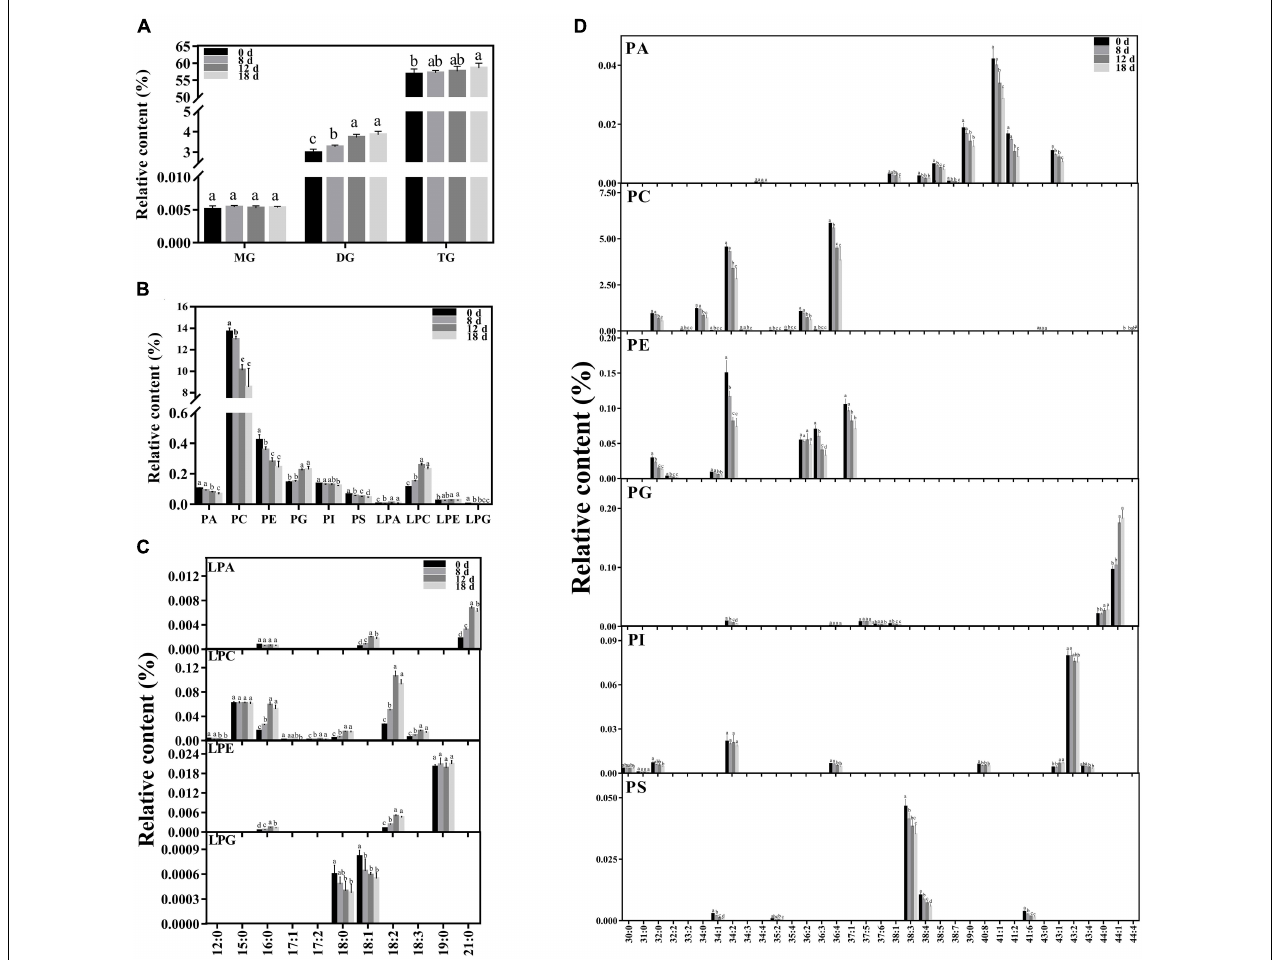
FIGURE 5 | Changes in lipid composition during seed aging. (A) Glycerolipid composition changes during seed aging. (B) Phospholipid composition changes during seed aging. (C) Lysophospholipid composition changes during seed aging. (D) Phospholipid molecular species composition changes during seed aging. Data shows the mean ± SD of six biologically independent experiments. Columns marked with different letters (a-d) are statistically significantly different ( p < 0.05). Lipid molecular species are identified as total acyl carbons: total double